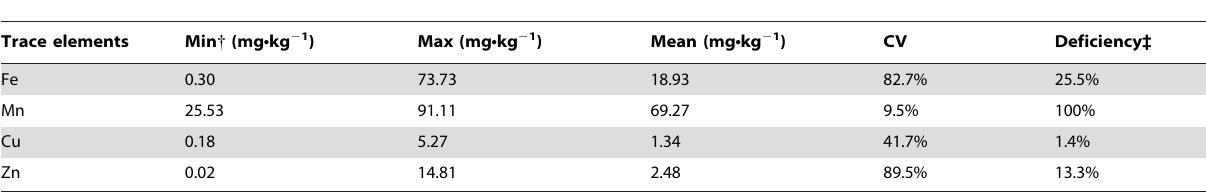
Table 1. Descriptive statistics for selected soil trace elements in the study agricultural field of northeast China.